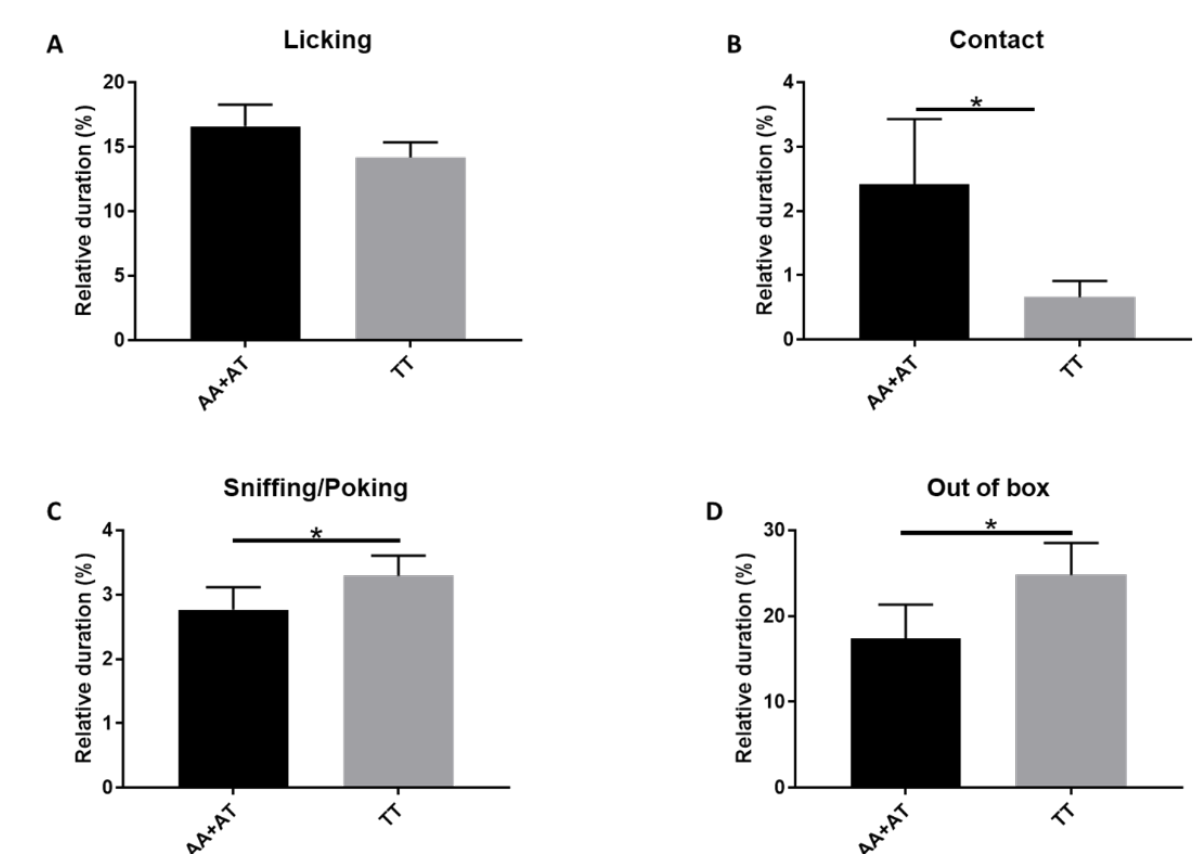
Figure 2. The correlation between OXTR gene polymorphism and relative duration (%) of maternal behaviors: ( A ) Licking, ( B ) Contact, ( C ) Sniffing/poking, ( D ) Out of box. The presence of the A allele (AA + AT) in rs 8679684 SNP was associated with a higher level of licking ( p = 0.1870) and contact ( p = 0.0468), but with a lower level of sniffing/poking ( p = 0.0374) and out of box ( p = 0.0432) (* p ≤ 0.05—Mann–Whitney test).